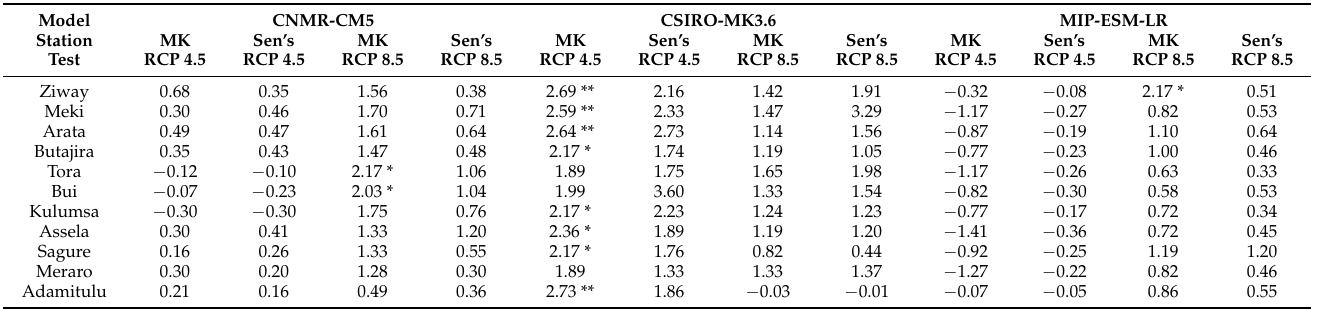
Table A6. Projected Mann–Kendall trend and Sen’s slope estimator results average rainfall for 11 stations over Ziway Lake Basin from the period 2050–2072.